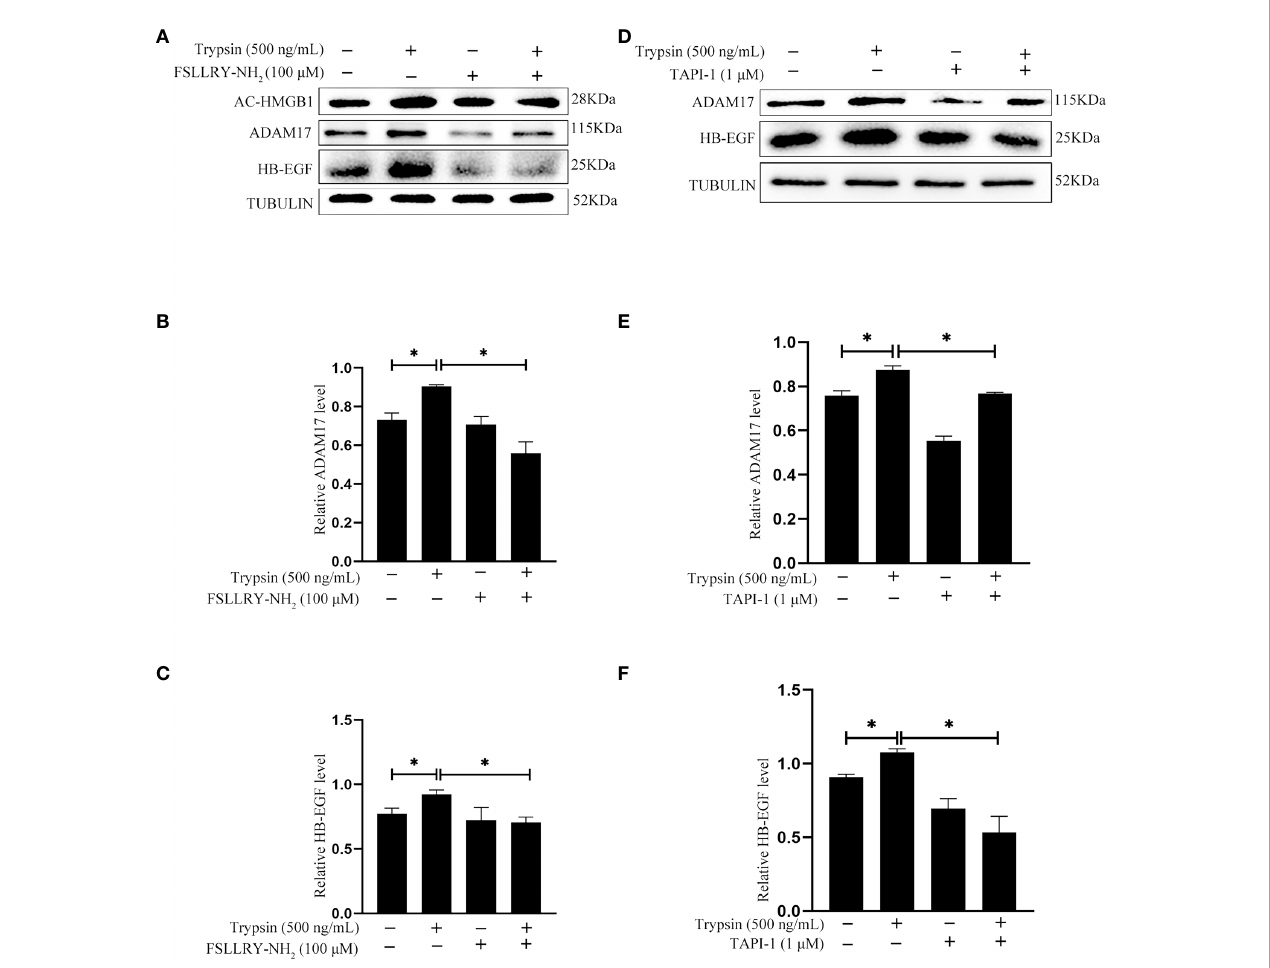
FIGURE 7 Effects of PAR2 inhibitor and ADAM17 inhibitor on the protein levels of acetylated HMGB1, ADAM17 and HB-EGF after human Ishikawa cells were treated with 500 ng/ml trypsin. (A) Western blot analysis on the protein levels of acetylated HMGB1, ADAM17 and HB-EGF when Ishikawa cells were pretreated with 100 m M FSLLRY-NH 2 for 24 h and further treated with 500 ng/ml trypsin in the absence or presence of FSLLRY-NH 2 . (B, C) The relative protein levels of ADAM17 and HB-EGF in Figure 7A. (D) Western blot analysis on the protein levels of ADAM17 and HB-EGF when Ishikawa cells were pretreated with 1 m M TAPI-1 for 30 min and further treated with 500 ng/ml trypsin for 15 min. (E, F) The relative protein levels of ADAM17 and HB-EGF in Figure 7D.*, p